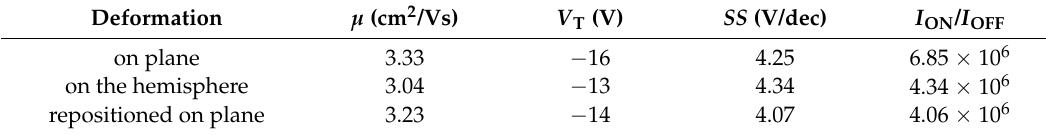
Table 1. The calculated field-effect parameters of the C8-BTBT OTFT under three deformation states.